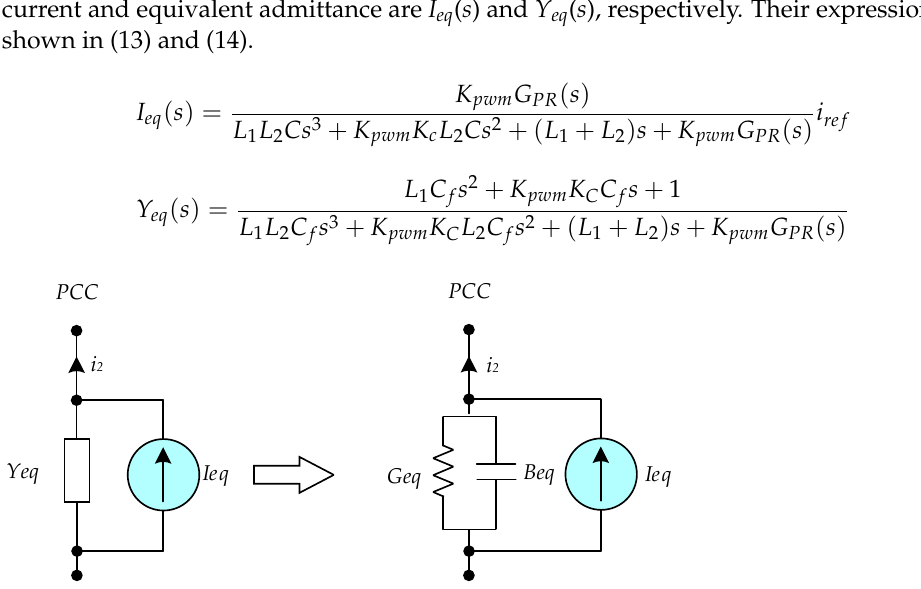
Figure 2. The control diagram of the current and damping control loop.